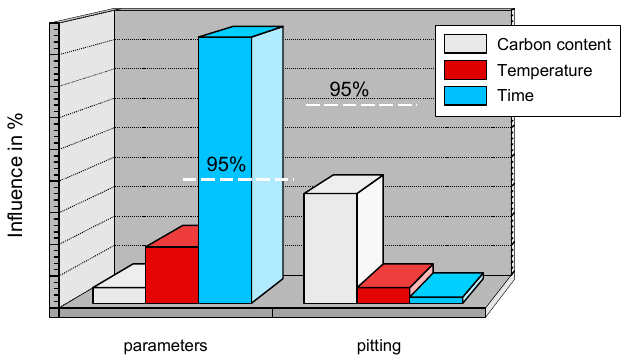
Figure 17. The impact of the experimental parameters on the corrosion rate after 4000 h of exposure time combined with confidence intervals.